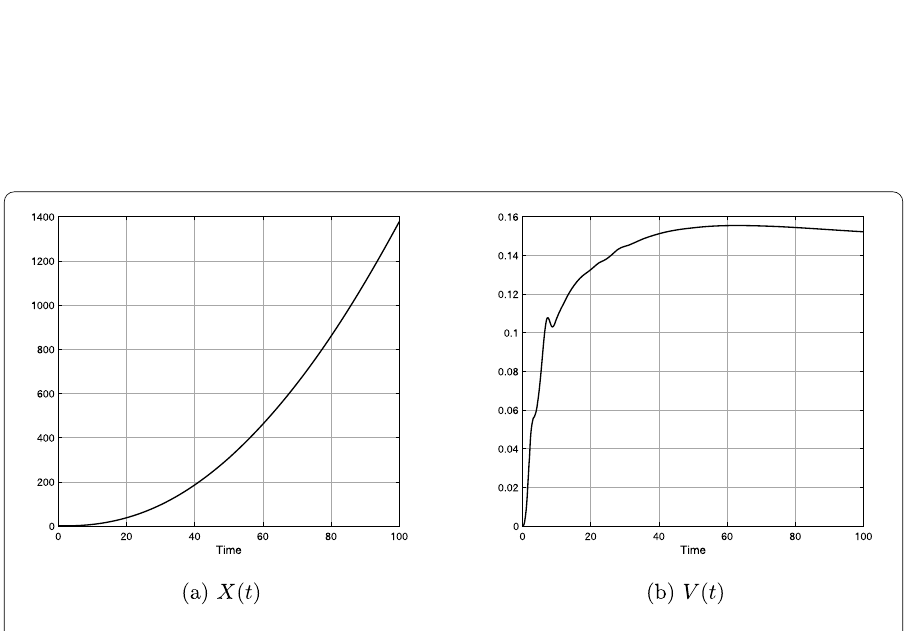
Figure 11 Dispersion and disagreement of Case III for t ∈